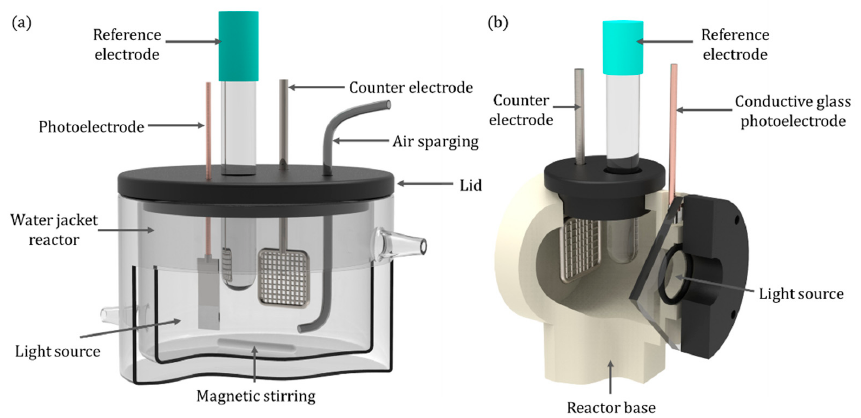
Figure 8. ( a ) Quartz water-jacketed PEC; ( b ) a back-face irradiated reactor.